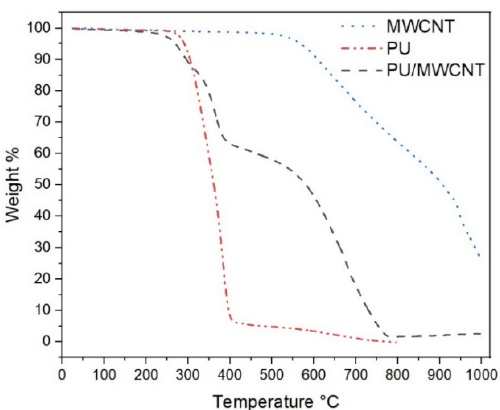
Figure 5. Thermogravimetric (TGA) curves of MWCNT (dot line), Thermoplastic polyurethane PU (dash dot dot line), PU/MWCNT composite (dash line).